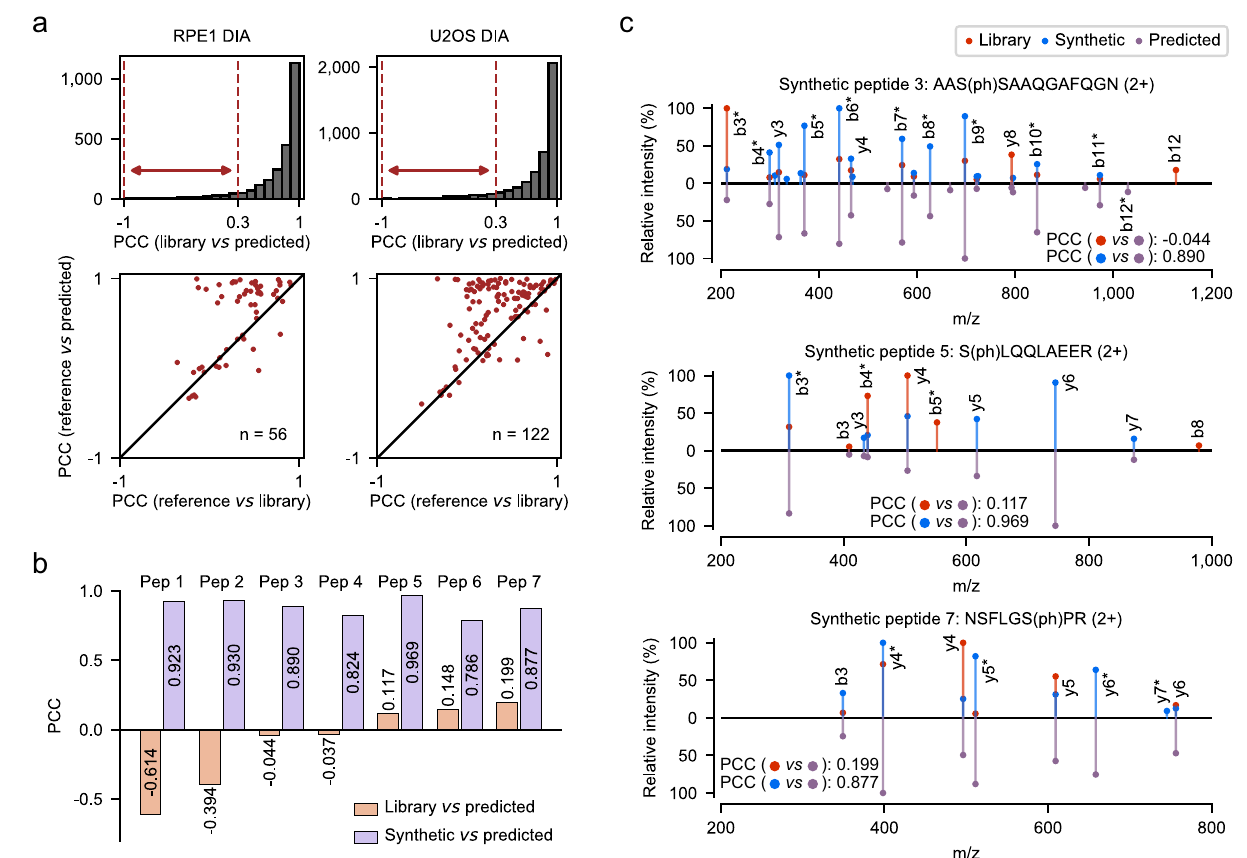
Fig. 2 MSMS spectra prediction by DeepPhospho pinpoints possibly false identi fi cations in an experimental library. a Distribution of PCC between spectra predicted by DeepPhospho vs spectra assigned in the DIA library for two datasets (upper). For phosphopeptides of low spectral similarity (PCC within − 1 to 0.3), their PCC distribution are calculated between predicted spectra vs reference spectra, and between predicted spectra vs DIA library spectra, and plotted around the diagonal (lower). Reference spectra were obtained by gold-standard DDA analysis of the same phosphopeptide samples. b Correlation between the predicted spectra and the high-quality spectra of the synthetic peptide, and between the predicted spectra and the DIA library spectra, for seven selected phosphopeptides. c Spectra mirror plots for phosphopeptides show much higher similarity between the predicted spectra, and the synthetic peptide spectra than between the predicted spectra and the DIA library spectra. Relative fragment ion intensities in the predicted spectra, the DIA library spectra and the synthetic peptide spectra are annotated by purple, orange and blue lines. * Indicates the loss of a phosphate. Source data for this fi gure are provided as a Source data fi